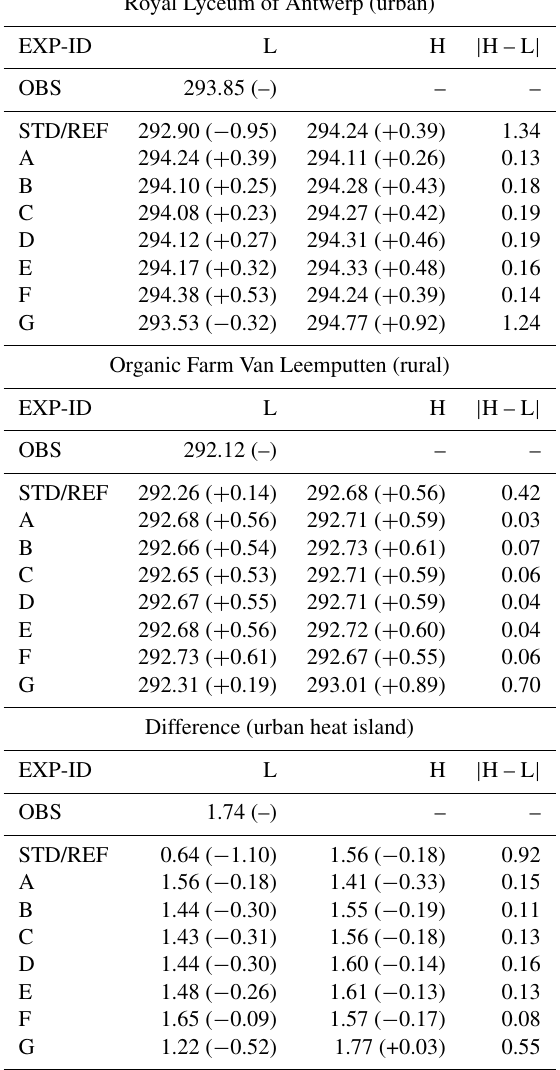
Table 3. Daily averages for modelled and observed temperatures (unit: K) during mid-summer (21 July to 20 August 2012) at the Royal Lyceum for Antwerp (urban), the Organic Farm Van Leem- putten (rural) and their difference (the urban heat island effect of Antwerp). Each first row shows results of the observations. Each second row shows results for COSMO-CLM model without urban parametrization (L column), for COSMO-CLM plus TERRA_URB v2.0 (H column) and their absolute difference ( | H − L | column). The remainder rows show each of the urban-parameter sensitivity simulations in Table 2. Therefore, the low scenarios are shown in the L column, the high scenarios in the H column and the param- eter sensitivity range (absolute difference between L and H) in the | H − L | column.